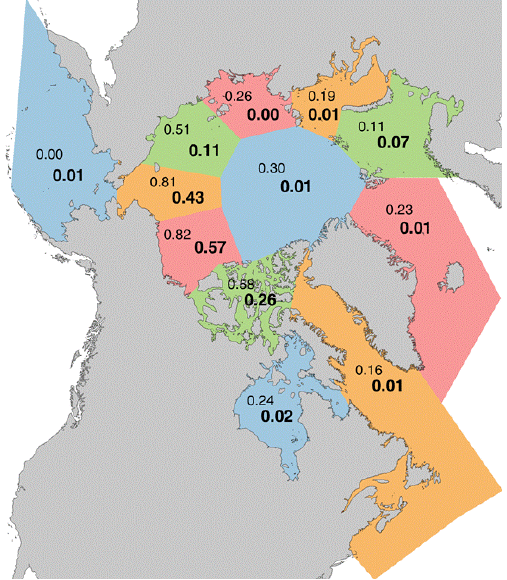
Figure 8. As in Fig. 7, but for squares of correlations between the annual BSI and September regional ice extents based on raw (not detrended) time series (upper numbers) and detrended time series (lower numbers, bold font). The 95% significance thresholds for the R 2 values range from 0.07 with no autocorrelation (generally the case for detrended data) to 0.14 with an autocorrelation of 0.4.